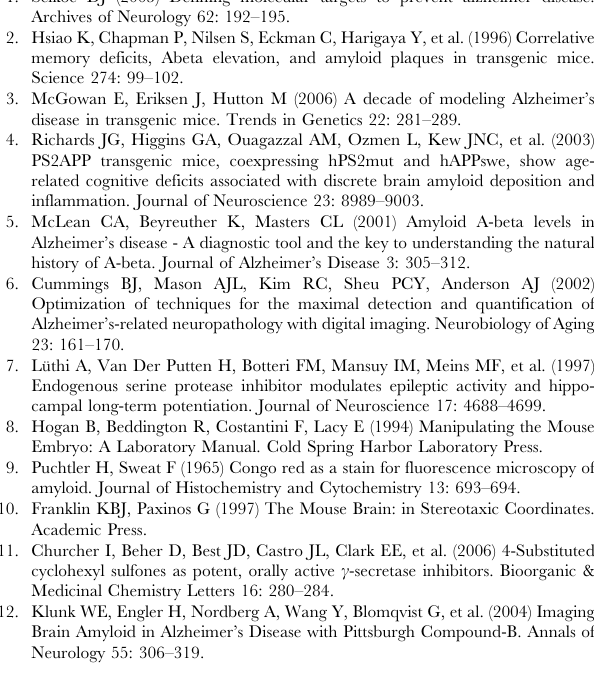
Figure S8 Immunohistochemical detection of A b (6E10, green) in parasagittal brain sections of representative hemi- (tg) and homozygous (tg/tg) ARTE10 mice at different ages (3, 8, 12, and